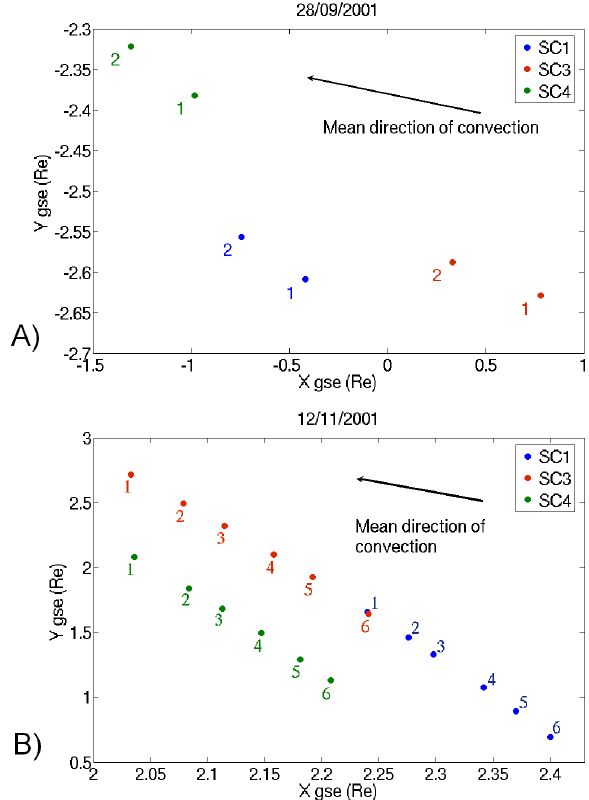
Fig. 9. Cluster spacecraft location at their encounter with the ion energetic structures. The number refers to the structures’ label as given in Figs. 3 and 7. It must be taken into account that the ratio of the X and Y axes differs from one panel to